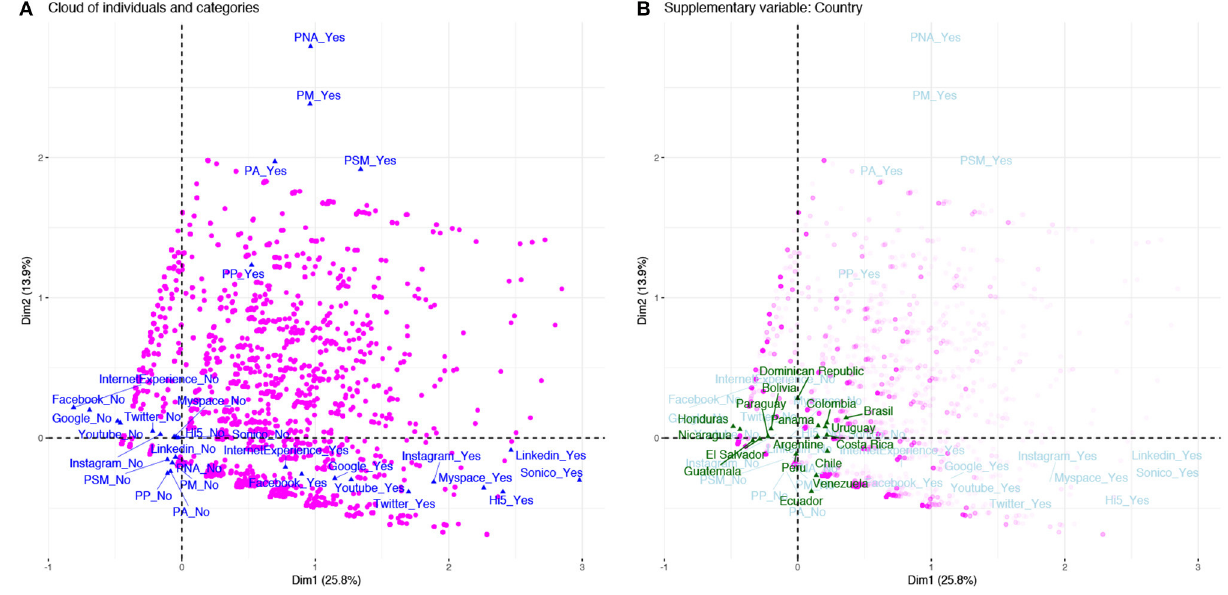
19,050 individuals). (A) Two-dimensional protection of individual cloud =